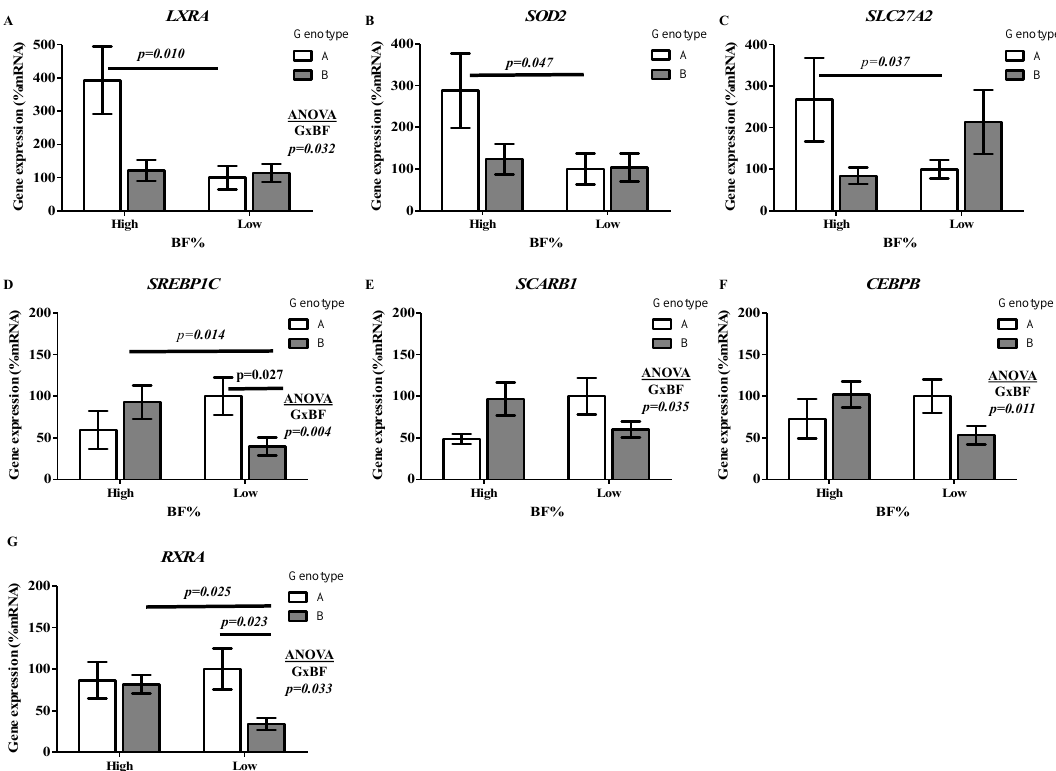
Figure 2. Gene expression under basal conditions in Peripheral Blood Mononuclear Cells 1 . 1 Gene expression under basal conditions in Peripheral Blood Mononuclear Cells (PBMCs) of subjects according to genotype (A / B) and BF% level (High / Low) groups. Data correspond to mRNA levels of genes encoding transcription factors involved in cellular response to retinoic acid, lipid, and energy metabolic homeostasis: ( A ) Liver X Receptor alpha (LXRA), ( B ) Superoxide dismutase 2 (SOD2), ( C ) Very long-chain acyl-CoA synthetase (SLC27A2), ( D ) Sterol Response Element Binding Protein 1c (SREBP1C), ( E ) Scavenger Receptor Class B Member 1 ( SCARB1 ), ( F ) CCAAT / enhancer-binding protein beta (CEBPB), and ( G ) Retinol-X Receptor α (RXRA). The mRNA levels were normalized to RPLP0 and expressed in relation to the expression found in Genotype A and Low BF% which was set at 100%. The statistical analysis of genotype–BF% interaction was carried out by ANOVA adjusted for total energy intake and age; GxBF indicates p < 0.05. Di ff erences between genotype groups were established by an ANOVA test adjusted for total energy intake. Di ff erences between BF% groups were analyzed by an ANOVA test adjusted for age.